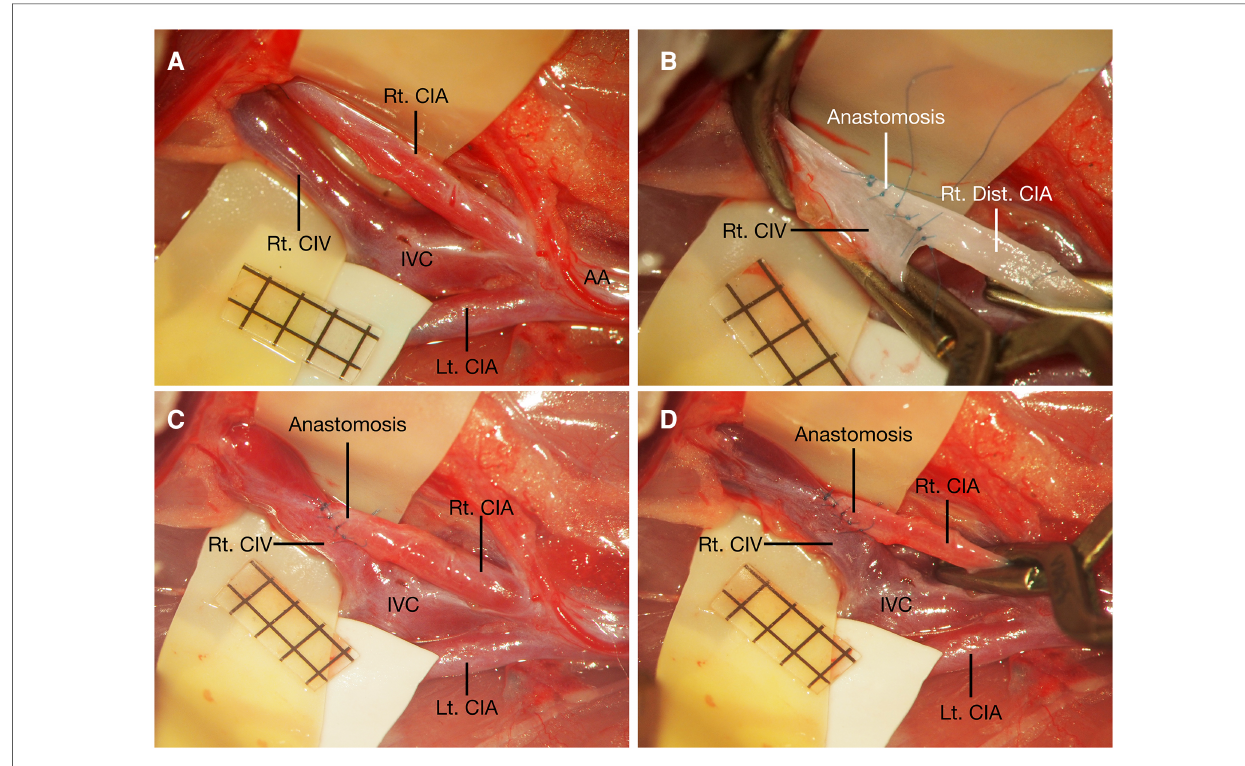
FIGURE 5 Distal CIA to ipsilateral CIV end-to-side anastomosis. After right CIA and CIV were fully dissected ( A ), the distal cutting end of the right CIA was sutured to the side of the right CIV ( B ). After restoration of blood fl ow, right CIV appeared to be bright red-colored and expanded through patent anastomosis due to arterial blood fl ow from CIA ( C ), and the color of the right CIV turned back to dark red again when the right CIA was temporarily occluded ( D ). Scale bar= 1 mm. AA, abdominal aorta; CIA, common iliac artery; CIV, common iliac vein; IVC, inferior vena cava; Lt., left; Rt., right.